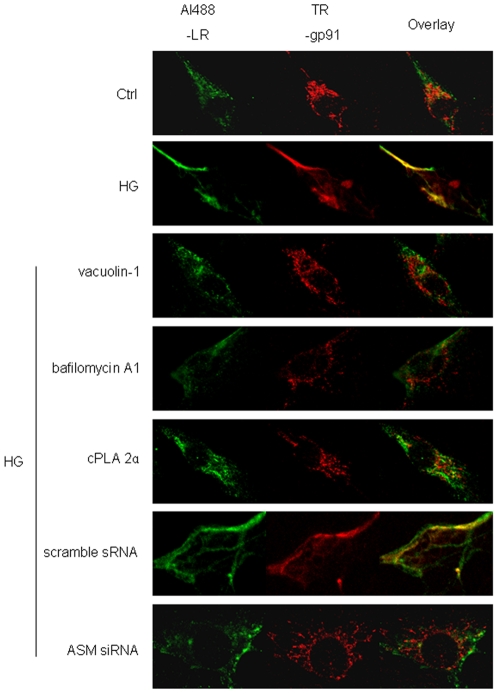
Effects of HG incubation on the colocalization of gp91phox to LRs and the representations after inhibition of lysosome-membrane fusion.Representative confocal images showed Alexa Fluo 488 conjugated cholera toxin B labeled LRs clusters (Al488-LR) and Texas red labeled gp91phox (TR-gp91) in cell incubated by normal glucose (Ctrl) or high glucose for 12 h (HG) with or without the pretreatment by vacuolin-1(10 µmol/l for 1 h), bafilomycin A1 (100 nmol/l for 1 h), cPLA 2α (20 µmol/l for 1 h), scramble sRNA transfection or ASM siRNA transfection. The overlay images exhibited yellow spots or patches (right), which represented colocalization of gp91phox with LRs component, ganglioside GM1.2. The figure showed representative images from experiment of 5 batches of HUVEC.